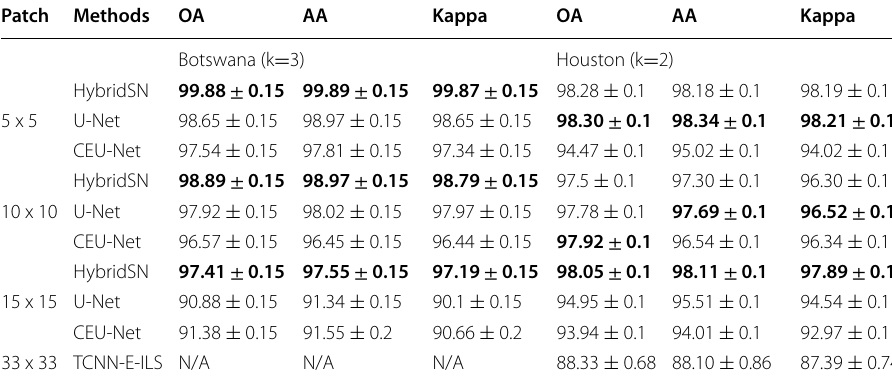
20. An explanation =